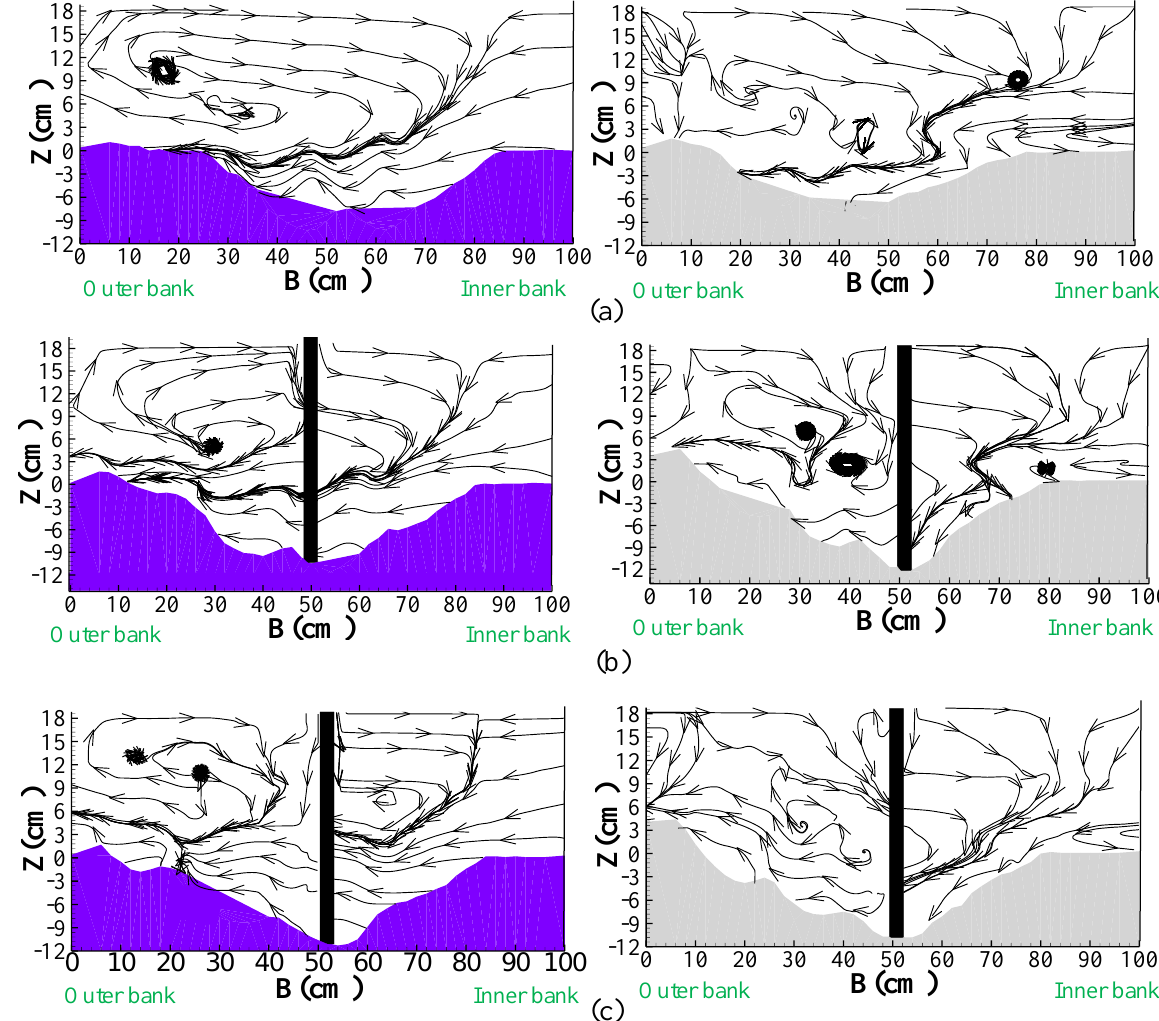
Figure 4. A view of the flow pattern at a) 86, b) 89, and c) 90.5 degree cross sections in the bend. (PFV experiment on the right, and PSV experiment on the